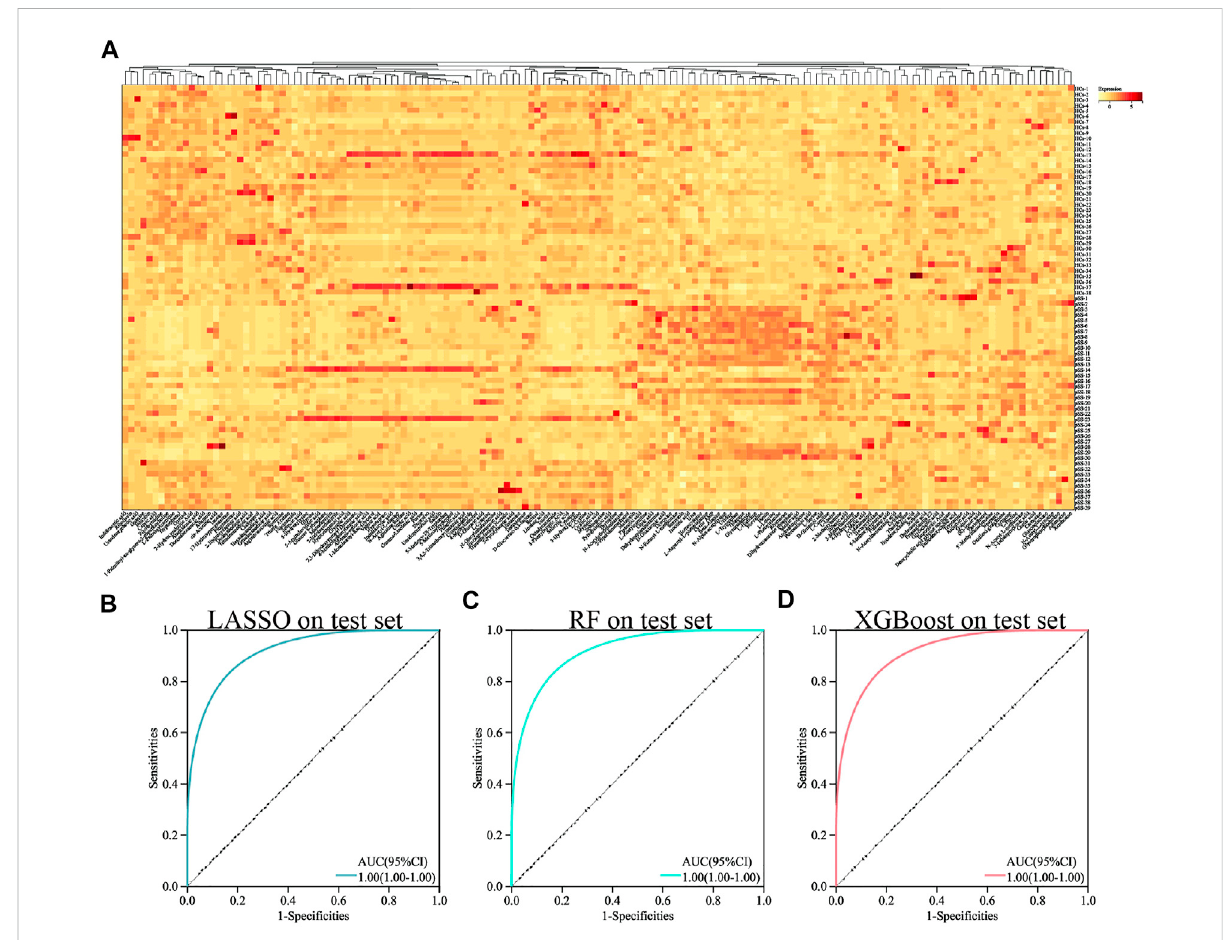
FIGURE 1 Heat map and ROC curve of different machine learning methods in all metabolites. Heat map of all metabolites (A) . ROC curve of LASSO in all metabolites (B) . ROC curve of RF in all metabolites (C) . ROC curve of XGBoost in all metabolites (D) .